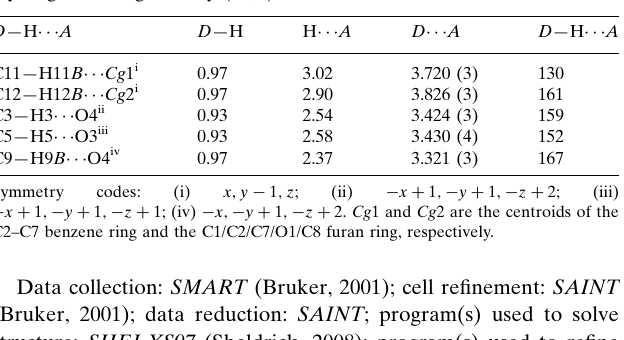
Hydrogen-bond geometry (A˚ , (cid:2)